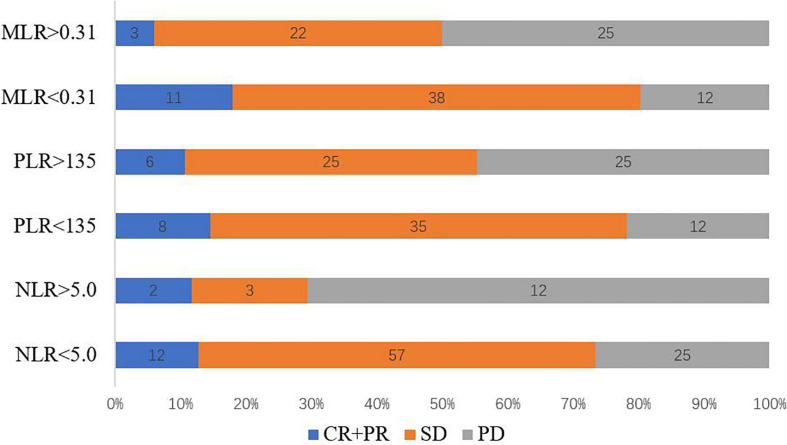
Response rates corresponding to baseline NLR, PLR, and MLR. CR, complete response; MLR, monocyte-to-lymphocyte ratio; NLR, neutrophil-to-lymphocyte ratio; PLR, platelet-to-lymphocyte ratio; PR, partial response; SD, stable disease.